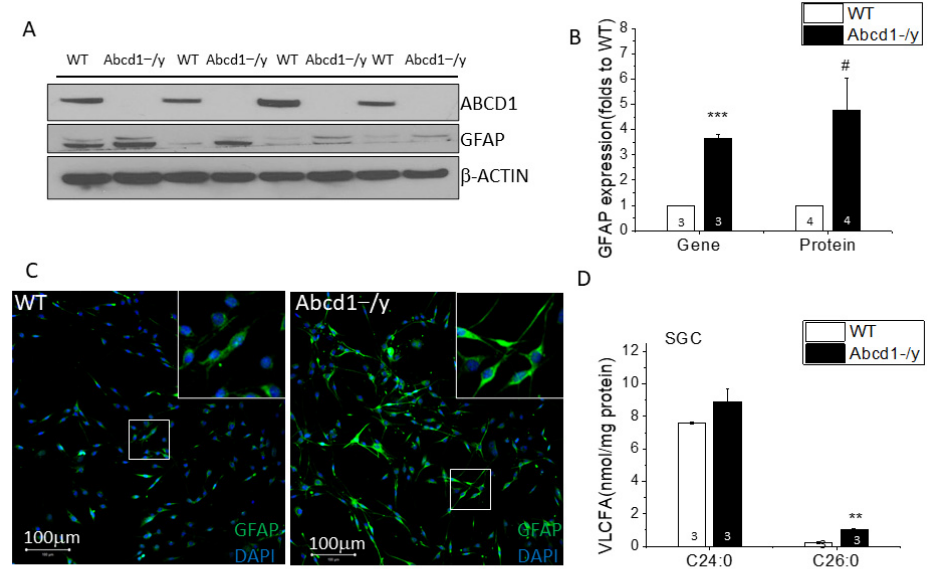
Figure 7. Gliosis and peroxisome dysfunction in satellite glial cells of Abcd1 − /y mice. ( A ) Western blot images showing increased GFAP expression in primary cultured Abcd1 − /y SGCs with β -ACTIN as loading control. ABCD1 expression confirmed knockdown in Abcd1 − /y mice. ( B ) Quantification of GFAP gene (qPCR) and protein expression in Abcd1 − /y SGCs ( n = 4 for protein groups and n = 3 for gene groups). ( C ) Representative confocal images showing increased GFAP staining (green) in primary cultured Abcd1 − /y SGCs. ( D ) Increased C26:0 and C24:0(nmol/mg protein) in primary cultured SGCs from Abcd1 − /y mice ( n = 3 for each group). Results were expressed as means ± SEM. # p < 0.05, ** p < 0.01, and *** p < 0.001 as compared with WT control.